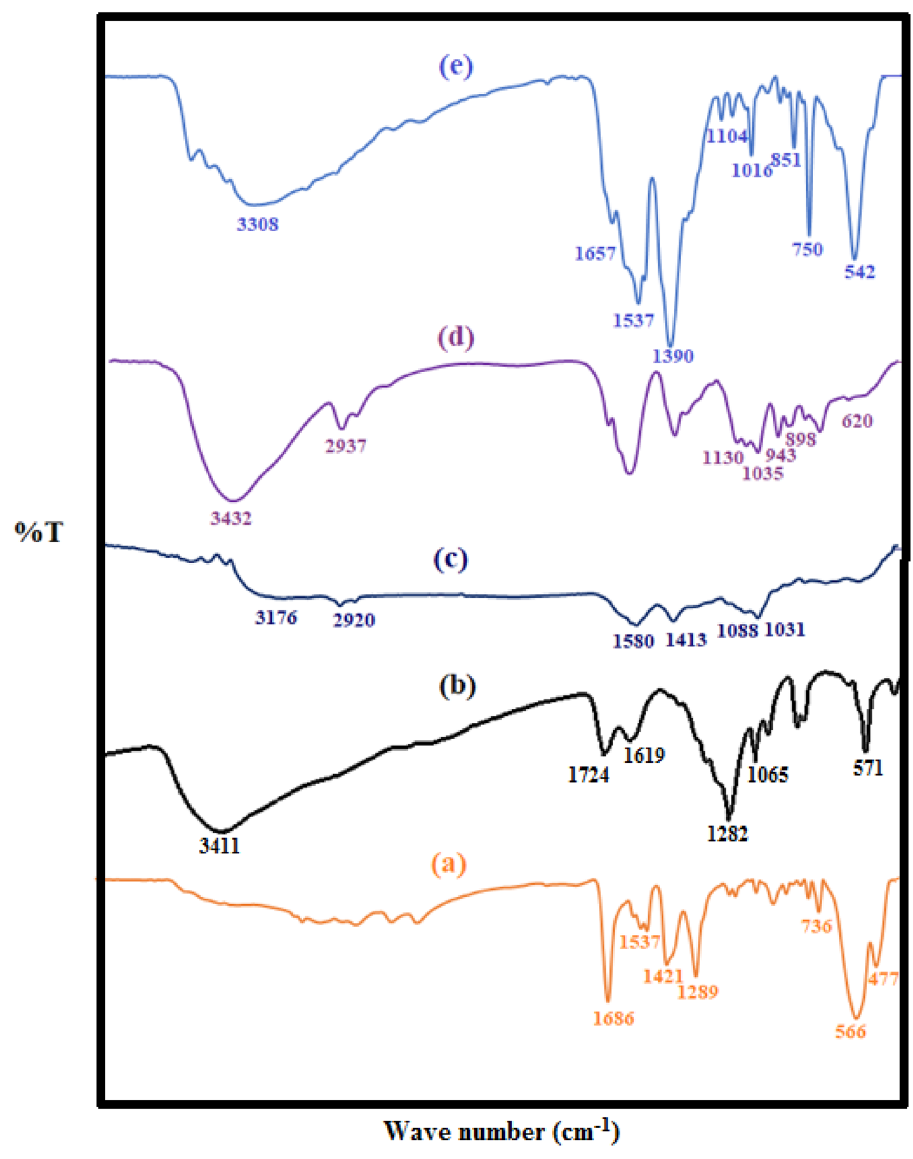
Figure 2. FT-IR spectra of ( a ) Fe 0.75 Cu 0.25 -BDC MOFs, ( b ) GO, ( c ) Alg-GO, ( d ) Alg-MoO 3 /GO and ( e ) Fe 0.75 Cu 0.25 -BDC@Alg-MoO 3